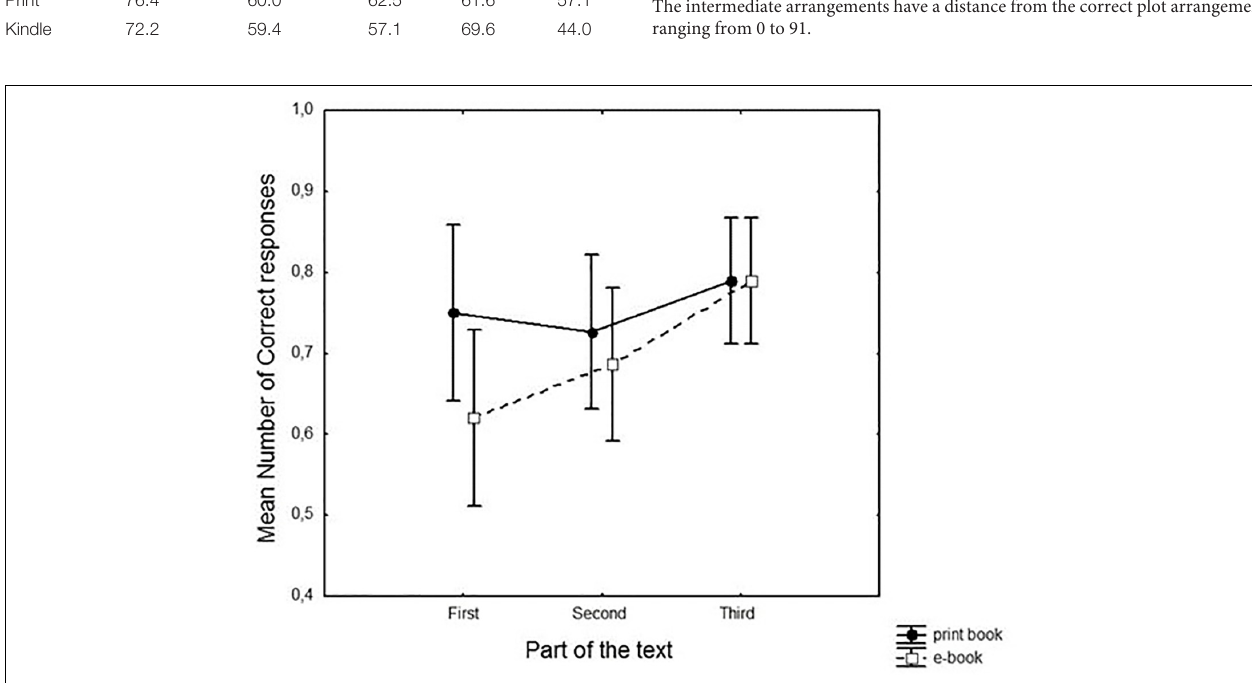
FIGURE 2 | Where in the text: rate of correct responses